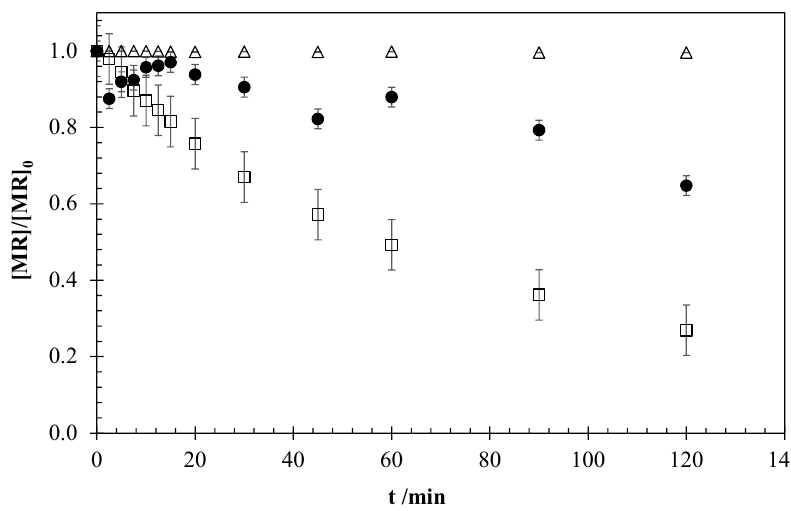
Figure 6. MR concentration profiles obtained for the experiments of sonolysis ( ∆ ), EO ( □ ), and the coupling of EO with ultrasound (Sono-EO) ( • ). Operation conditions: [MR] 0 = 5 mg dm − 3 , 15 mA cm − 2 , 0.051 M NaCl, US-40 kHz 100 W.